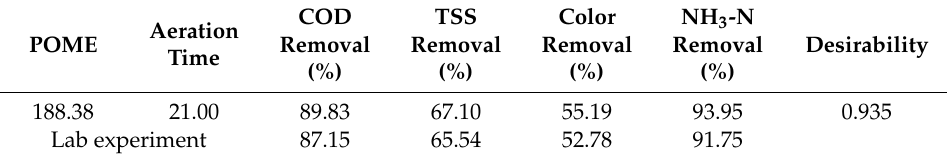
Table 5. Optimal response results from the model prediction and laboratory.